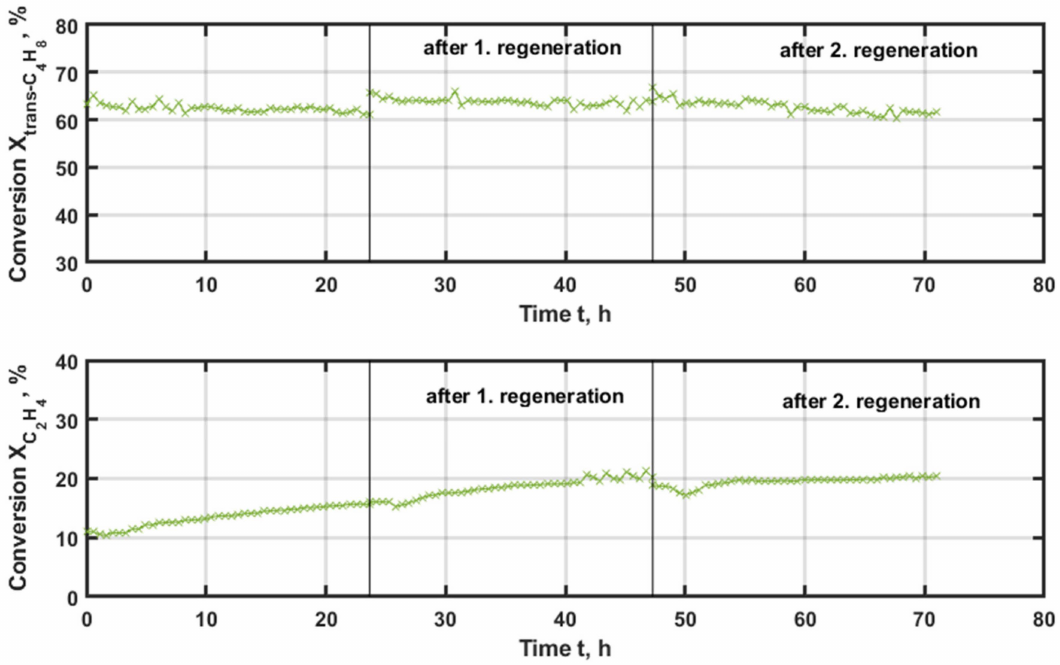
Figure 8. Conversion of the applied reactants trans-butene (upper graph) and ethene (lower graph) with time-on-stream (TOS) applying W/SiO 2 as the catalyst at 600 ◦ C and 500 kg cat · s · m − 3 , with regeneration at 500 ◦ C and 20% oxygen for 3 h.